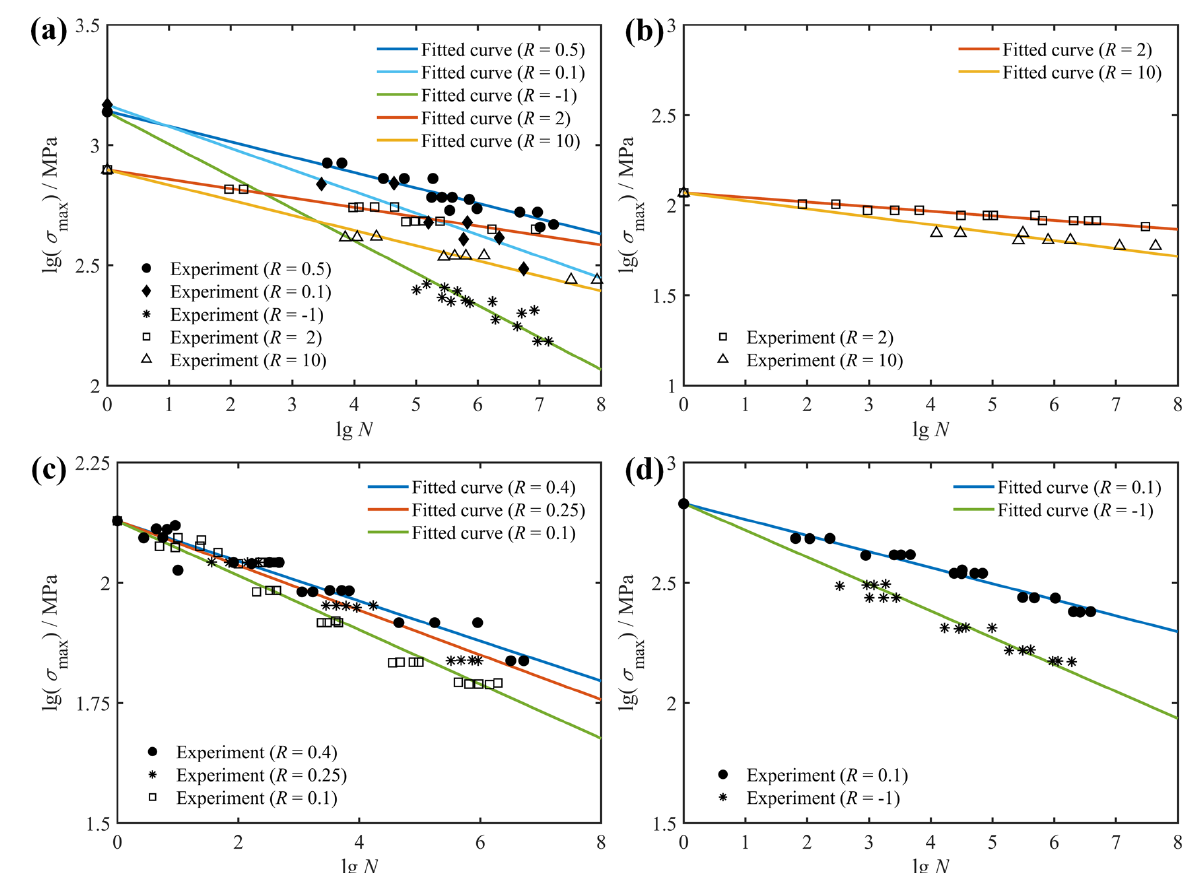
Figure 1. Effect of stress ratio on fatigue life of: ( a ) glass/polyester [0°] 8 ; ( b ) glass/polyester [90°] 4 ; ( c ) S2/glass/epoxy [±45°] S ; ( d ) DD5E-glass/epoxy [0°/±45°/0°] S , together with experimental data from Ref. [31].